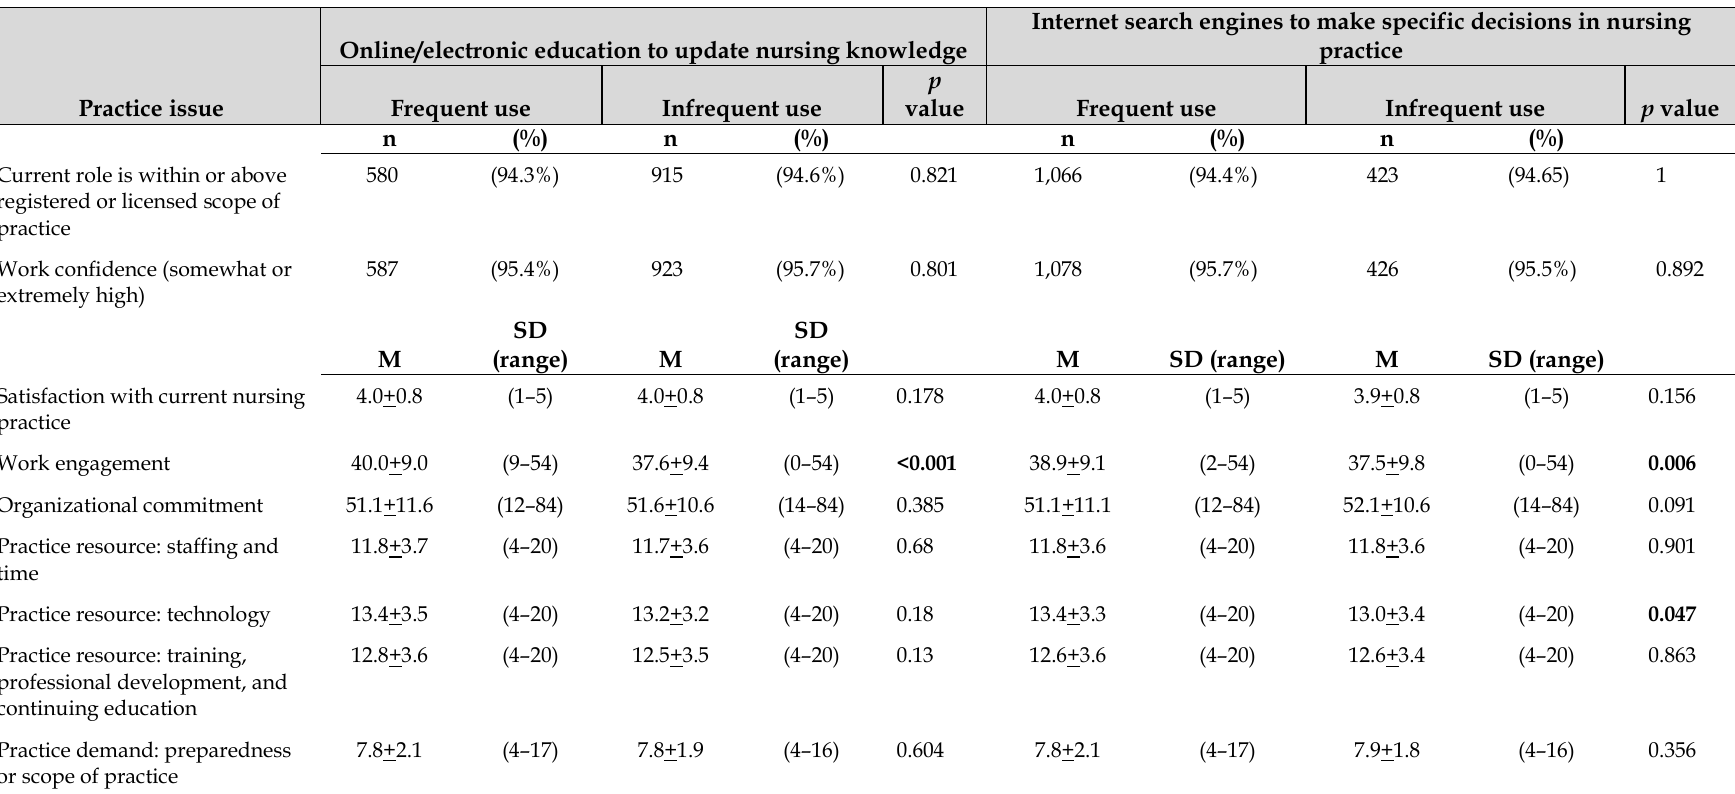
Table 6 Practice issues among registered nurses (RNs) by frequency of online/electronic education and Internet search engine